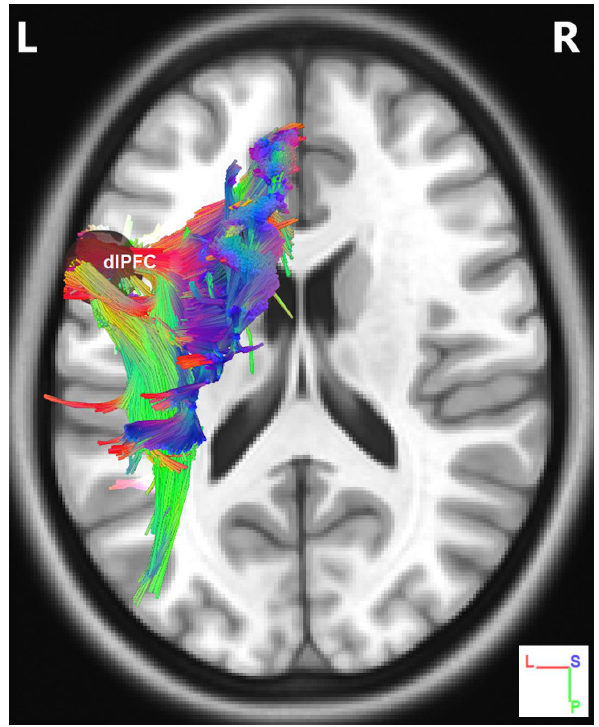
Figure 1. Fiber tracts crossing through seed region dlPFC for a representative participant. Here, fibers are colored-coded to represent their orientation, where “red” indicates fibers along the X - axis (i.e., left-right), “green” indicates fibers along the Y -axis (i.e., anterior-posterior), and “blue” indicates fibers along the Z -axis (i.e., inferior-superior).